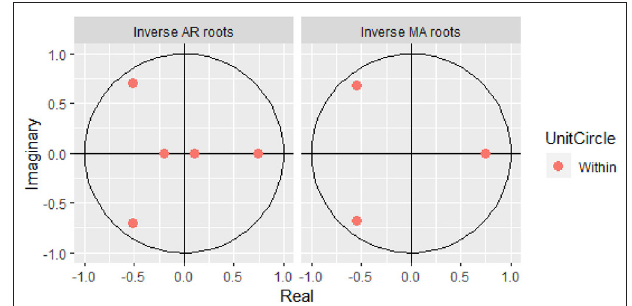
TABLE 7 | (A) Covariance matrix of the residuals, (B) Correlation matrix of residuals. Variable